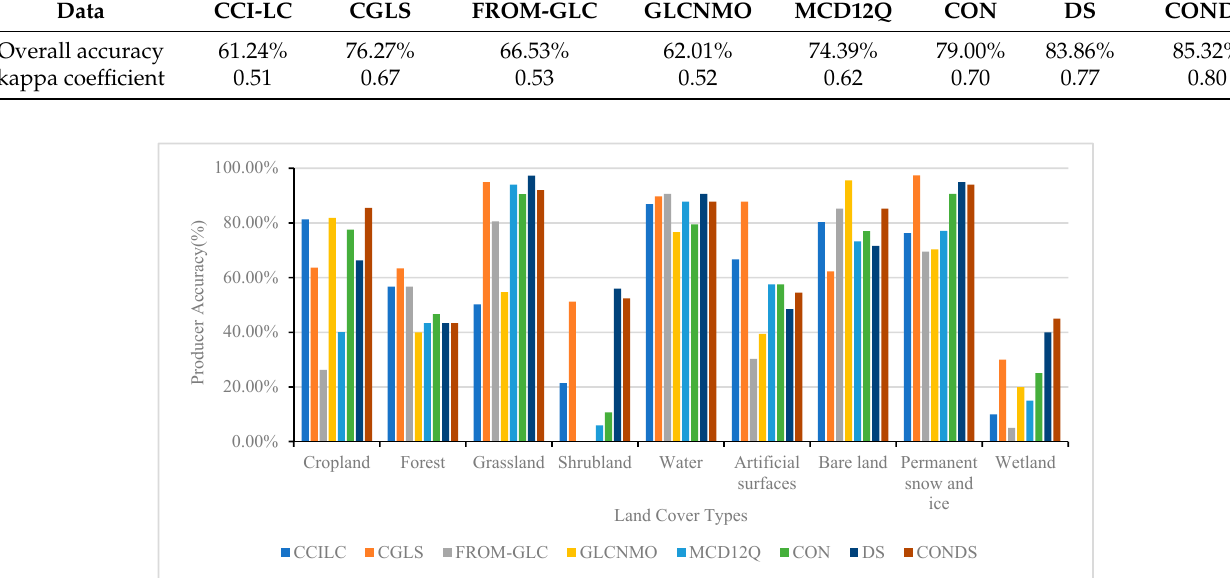
Table 4. The overall accuracy and kappa coefficient of multi-source landcover products and fusion results in Central Asia.